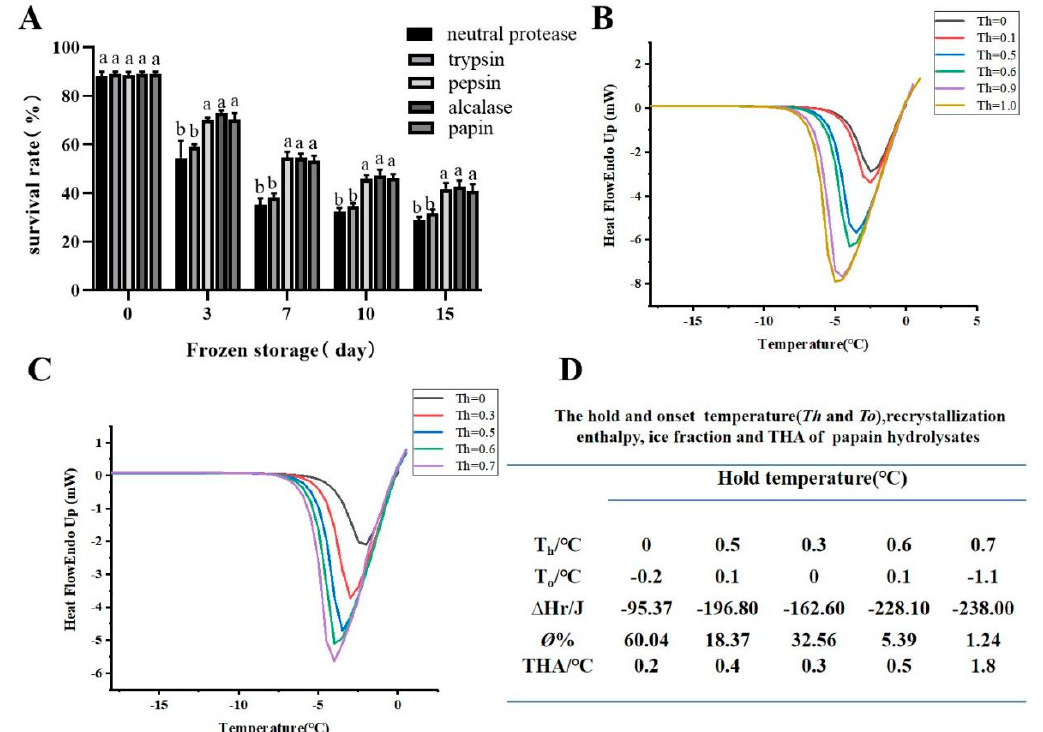
Figure 1. The hypothermia protective effects of 0.5% hydrolysates (trypsin, pepsin, alcalase, neutral protease, and papain) on yeast following 0, 3, 7, 10, and 15 d of freezing at − 20 °C ( A ). The DSC curves ( B ) of Ctenopharyngodon idella scale hydrolysates after enzymolysis with alcalase. The DSC curves ( C ) and THA activity ( D ) of Ctenopharyngodon idella scale hydrolysates after enzymolysis with papain. The data points represent mean values calculated from two separate experiments. Note: Means with the same letter in the same column showed no significant difference ( p ≥ 0.05).